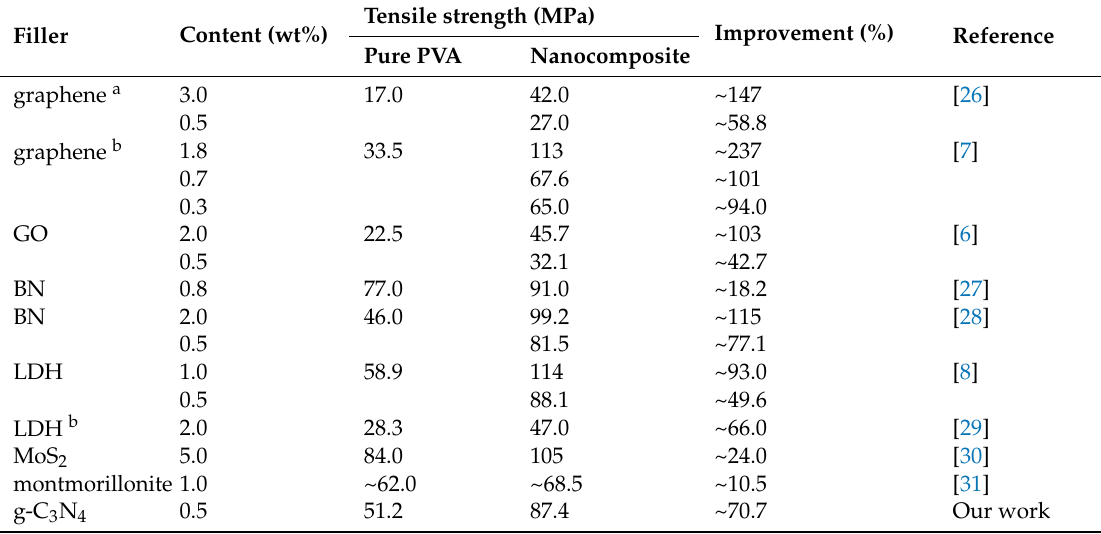
Figure 7. Stress–strain curves of pure PVA and PVA/g-C 3 N 4 nanocomposites. Table 2. Comparison of the improvement in tensile strength for the PVA nanocomposites filled with 2D nanofillers.